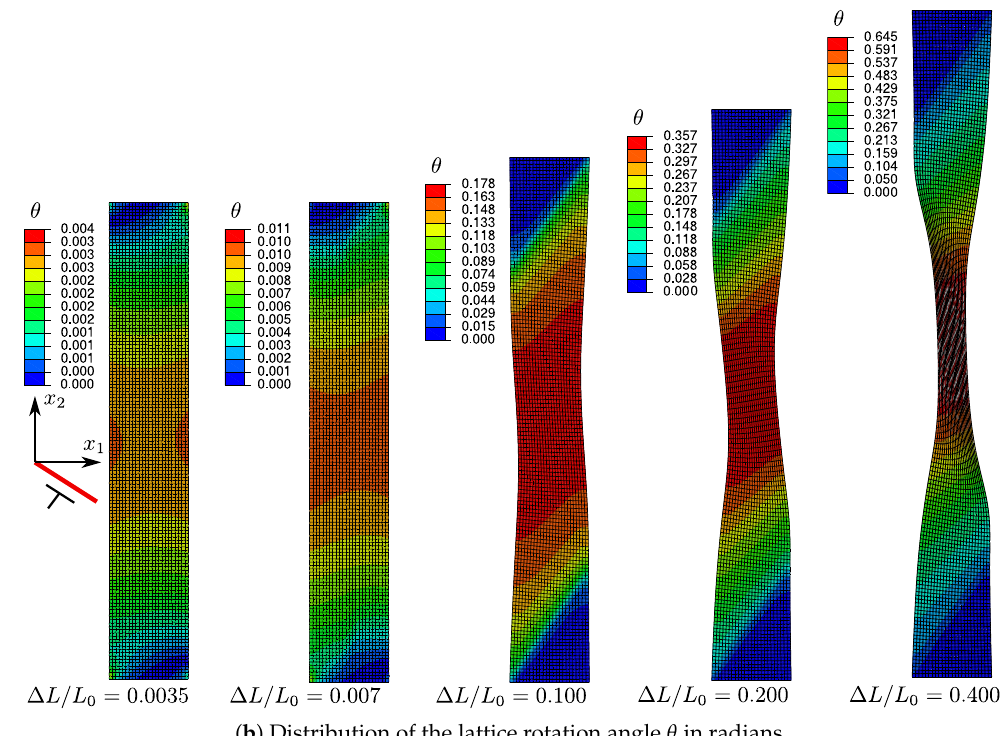
Figure 16. Evolution of the plastic slip variable γ and lattice rotation angle θ at different nominal tensile strains predicted by SGCP, including only higher-order dissipative effects with nonzero initial higher-order slip resistance S ξ 0 ( l en = 0, l dis / W = 0.25, S ξ 0 = 60.84 MPa, H ξ = 60.84 MPa).